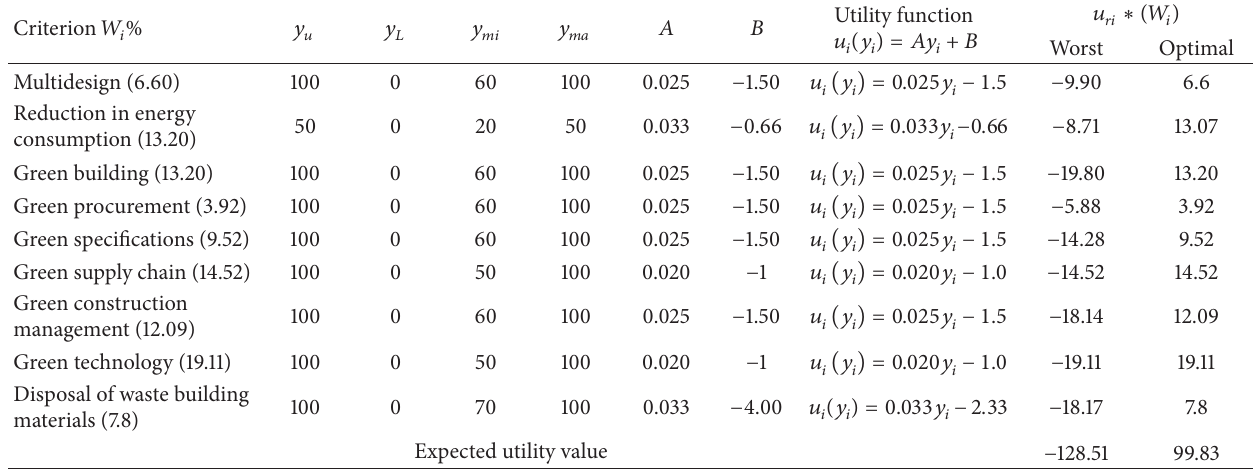
Table 9: Most preferred point, constants, UF, and expected utility value for criteria.